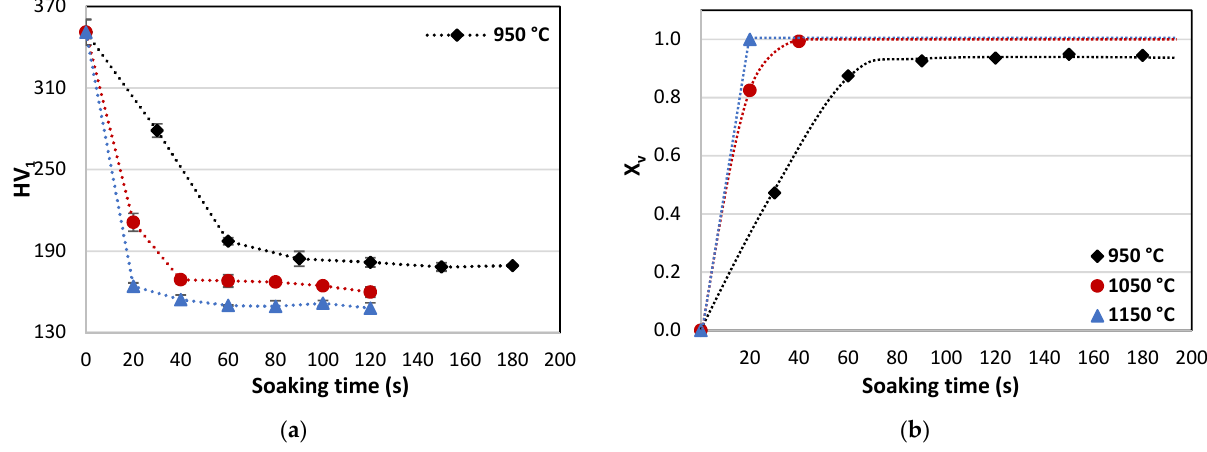
Figure 8. Effects of process parameters (temperature and soaking time) on hardness values HV 1 ( a ) and the recrystallized volume fraction X v ( b ) of AISI 904L cold-rolled at 70%.